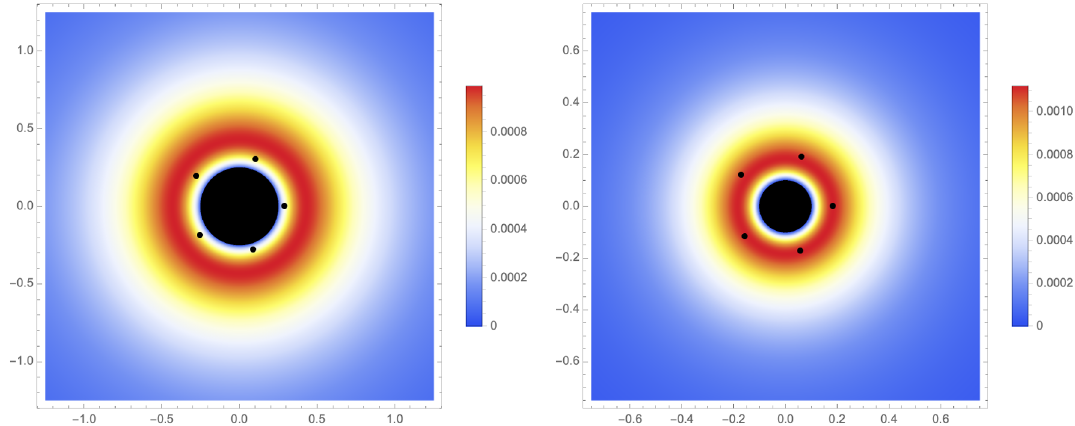
Figure 10 . On the left, the 2D plot of the massive vector field profile for the electric solution of figure 5. The metastable probes (with f = 5 / 8 , rightmost, and f = 9 / 5 the lowest one) lie close to the horizon, between the peak of the massive vector and the horizon. The other probes, starting from f = 3 / 4 (upper), f = 1 leftmost, f = 3 / 2 bottom left are all stable, and again their equilibrium distances lie behind the massive halo. Right: 2 metastable (rightmost, lowest) and 3 stable probes on the background solution characterized by pξ = pξ = − 0 . 194 , pξ = − 0 . 026 , T = 0 . 15 and 1 3 2 r H = 1 / 10 . We see that in this case the equilibrium distance for stable probes lies on top of the peak of the massive vector. Notice that only the probes with f = 1 come without strings